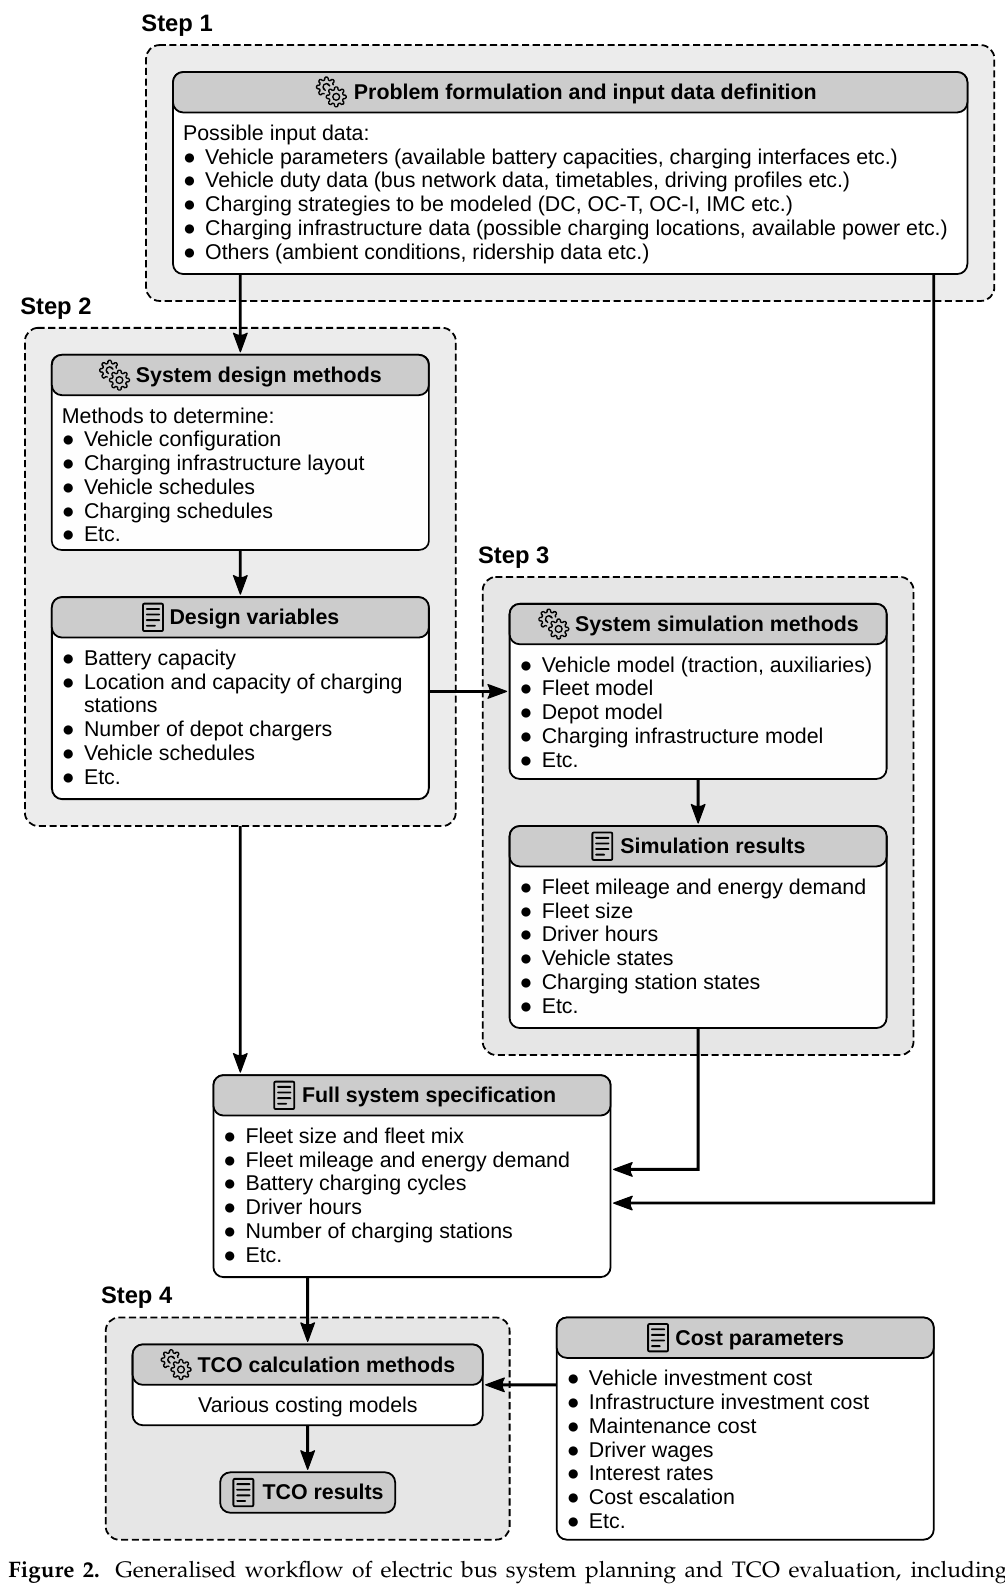
Figure 2. Generalised workflow of electric bus system planning and TCO evaluation, including examples of methods and data commonly used in the